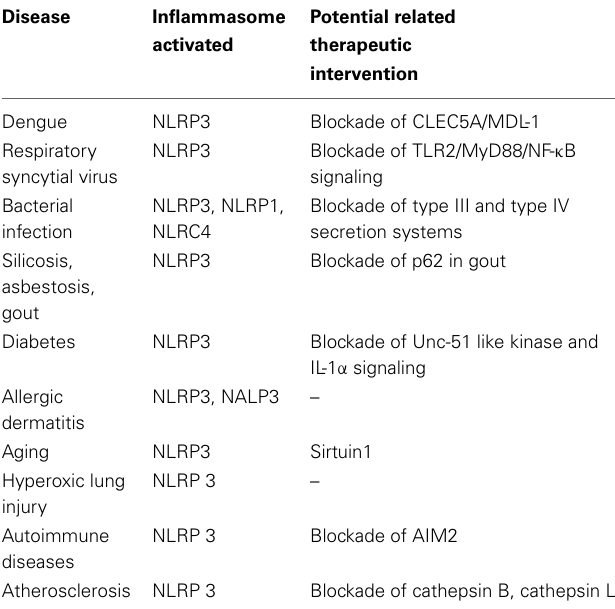
Table 1 | Types of inflammasome activated in various human diseases and the potential therapeutic